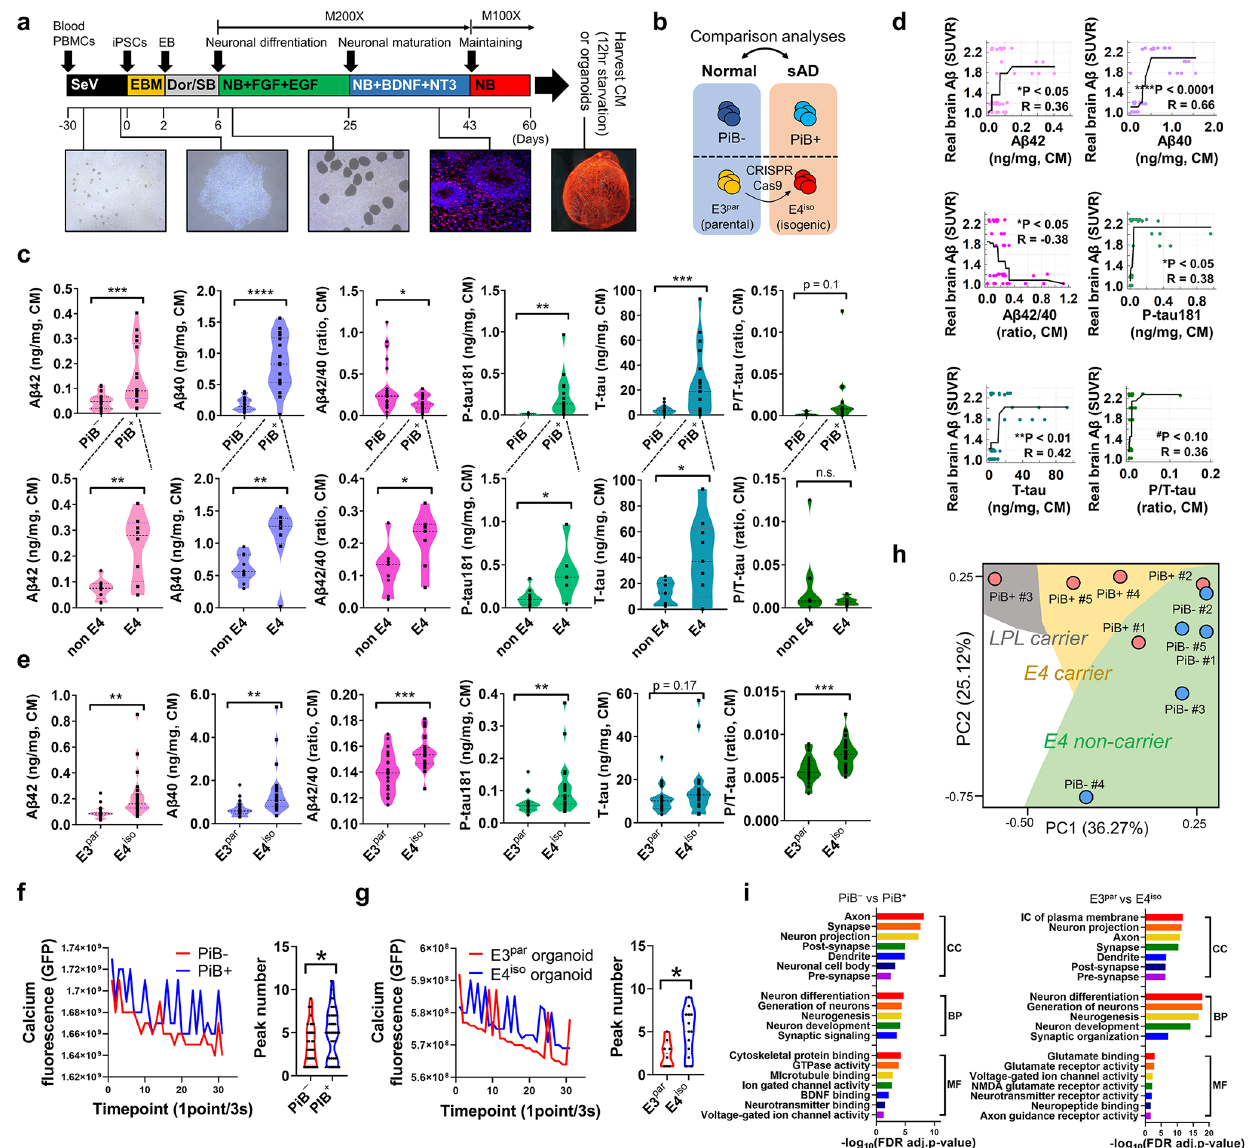
Fig. 2 Generation of sAD iCOs and their pathological features. a Generation of iCOs; 60 days-old iCOs were used for the experiments. b Experimental iCOs ’ sets for this study; The iCOs were from both Pittsburgh compound B (PiB)-PET negative/positive participants ’ iPSCs and ApoE3 (parental) /E4 (isogenic) iPSCs, which were generated by CRISPR-Cas9 gene-editing. c Quanti fi cation of AD hallmark proteins (A β 1-42, A β 1-40, total tau, p-tau) in the organoid conditioned media was performed between PiB − iCOs and PiB + iCOs (*** p = 0.0003 for A β 1-42, **** p < 0.0001 for A β 1-40, * p = 0.0384 for A β 1-42/1-40 ratio, ** p = 0.0042 for p-tau, *** p = 0.0002 for t-tau, p = 0.1025 for p/t-tau ratio; two-sided p -values; unpaired t -test; Each 3 – 7 iCOs was used from n = 8 participants) or between non-E4 carriers and E4 carriers (** p = 0.0020 for A β 1-42, ** p = 0.0082 for A β 1-40, * p = 0.0370 for A β 1-42/1- 40 ratio, * p = 0.0125 for p-tau, * p = 0.0173 for t-tau, p = 0.3296 for p/t-tau ratio; two-sided p -values; unpaired t -test; Each 3 – 7 iCOs was used from n = 4 participants). d Signi fi cant correlation was shown between the real human cerebral amyloid deposition (SUVR) and secreted AD hallmark proteins (* p = 0.0190 for A β 1-42, **** p < 0.0001 for A β 1-40, * p = 0.0183 for A β 1-42/1-40 ratio, * p = 0.0407 for p-tau, ** p = 0.0042 for t-tau, # p = 0.0550 for p/t-tau ratio; Pearson ’ s correlation; isotonic regression curve was shown). e Quanti fi cation of AD hallmark proteins (A β 1-42, A β 1-40, total tau, p-tau) in the organoid conditioned media was performed between E4 iso iCOs and E3 par iCOs (** p = 0.0013 for A β 1-42, ** p = 0.0034 for A β 1-40, *** p = 0.0007 for A β 1-42/1-40 ratio, ** p = 0.0094 for p-tau, p = 0.1720 for t-tau, *** p = 0.0003 for p/t-tau ratio; two-sided p -values; unpaired t -test; Each 24 iCOs was used from E4 iso iCOs and E3 par iCOs). f , g Comparison of physiological responses of the iCOs (calcium oscillation analysis) was performed between PiB − iCOs and PiB + iCOs or E4 iso iCOs and E3 par iCOs. PiB + iCOs and E4 iso iCOs had more number of peaks than PiB − iCOs and E3 par iCOs ( * p = 0.0399 for PiB − iCOs vs PiB + iCOs, * p = 0.0254 for E4 iso iCOs vs E3 par iCOs; two-sided p -values; unpaired t -test). h Principal component analysis (PCA) plot showing transcriptomic expression patterns in RNA sequencing data. i Transcriptomic GO analyses between the PiB − iCOs and PiB + iCOs or E4 iso iCOs and E3 par iCOs were performed with the FDR-adjusted p -value < 0.05 (adjustments were made for multiple comparisons; FDR-corrected by Toppgene analysis). p -value criteria: * p < 0.05, ** p < 0.01, *** p < 0.001, and **** p < 0.0001, two-sided p -values, unpaired t -test. PBMC peripheral blood mononuclear cells, SeV Sendai virus, EB embryoid body, Dor dorsomorphin, SB SB431542, NB neurobasal media, PiB Pittsburgh compound B, CM culture media, sAD sporadic AD, SUVR standardized uptake value ratio, A β beta-amyloid, p-tau phosphorylated tau, MF molecular function, BP biological process, CC cellular